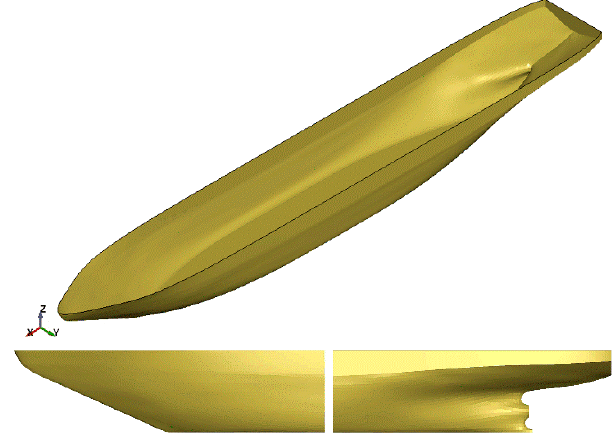
Figure 13. The geometry of the icebreaker Xue Long. Box plots of ice resistance and transverse force are presented in Figures 14 and 15. With